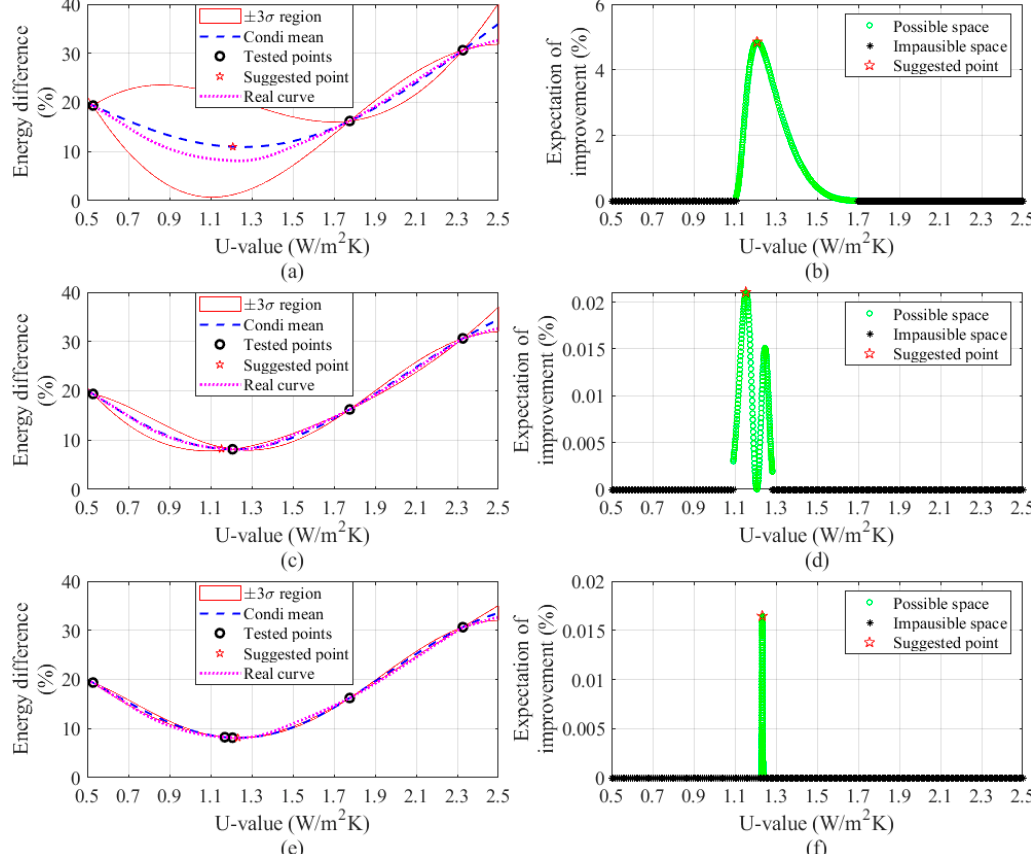
Figure 5. Results of one parameter calibration after each iteration. ( a ) Emulator’s result in the 1st iteration; ( b ) expected input space and suggested result in the 1st iteration; ( c ) emulator’s result in the 2nd iteration; ( d ) expected input space and suggested result in the 2nd iteration; ( e ) emulator’s result in the 3rd iteration; ( f ) expected input space and suggested result in the 3rd iteration.